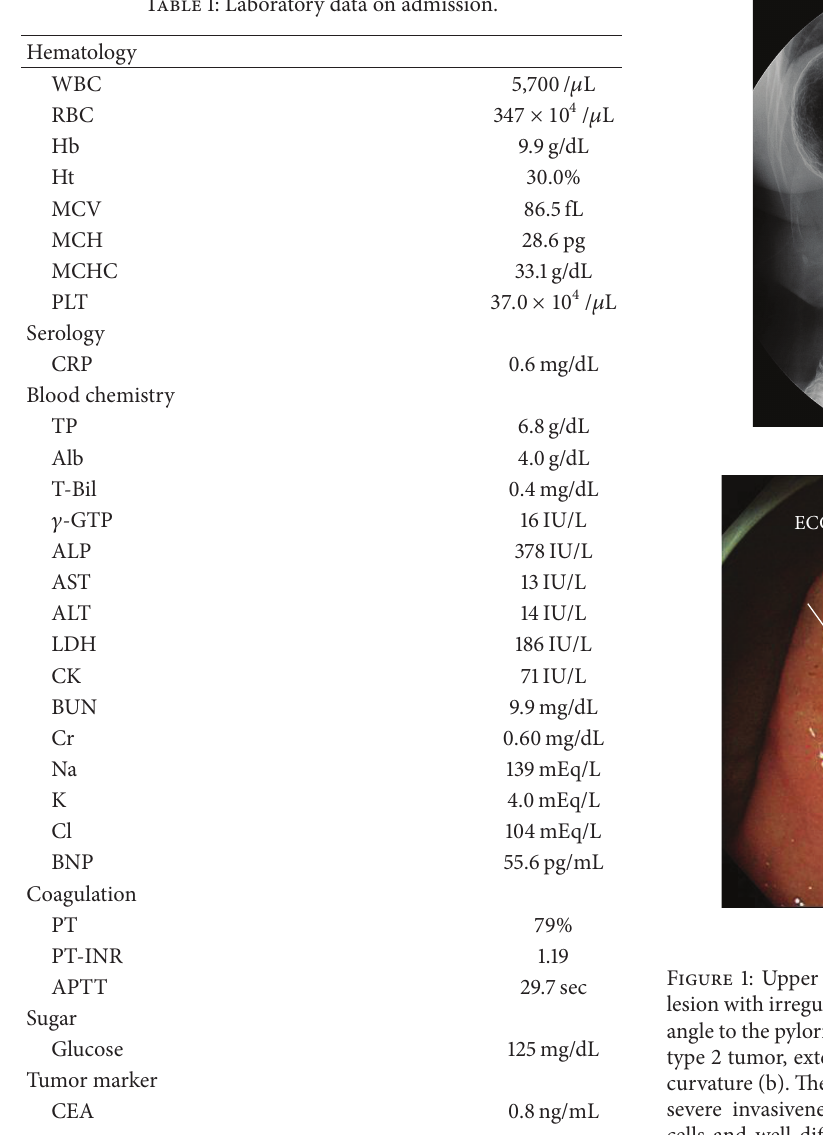
Table 1: Laboratory data on admission.